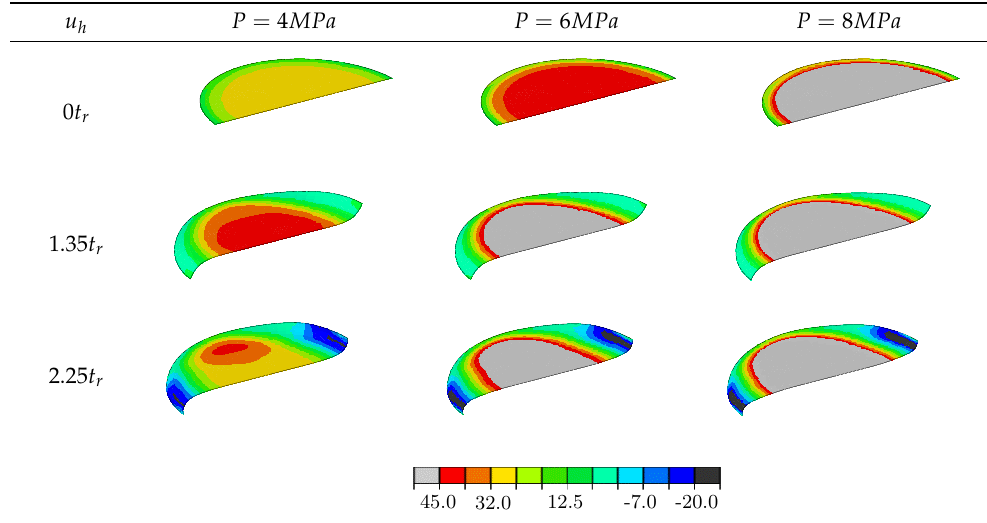
Figure 26. Influence of vertical pressure P on the axial stress S11 distribution in the carbon fiber reinforcement.